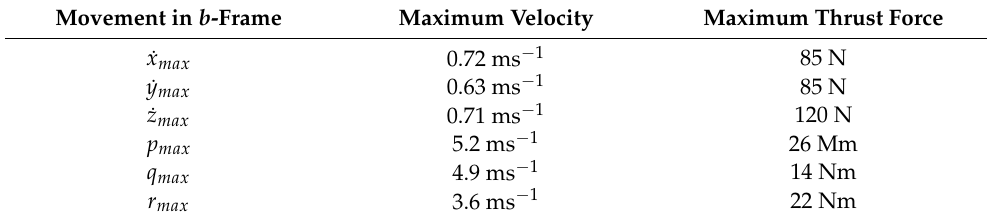
Table 4. Maximum velocities and forces in b